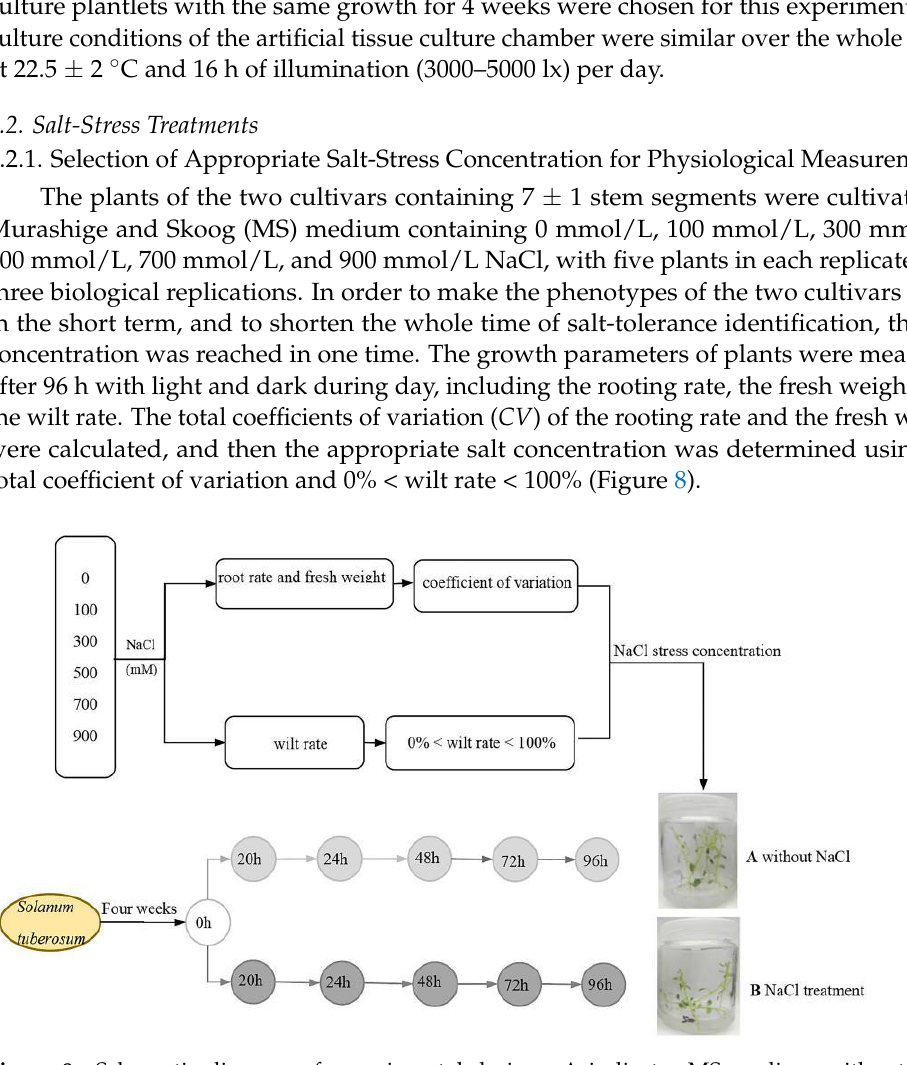
Figure − 8. Schematic diagram of experimental design. A indicates MS medium without NaCl. B in- dicates MS medium containing the suitable stress concentration of NaCl. B indicates MS medium containing the suitable stress concentration of